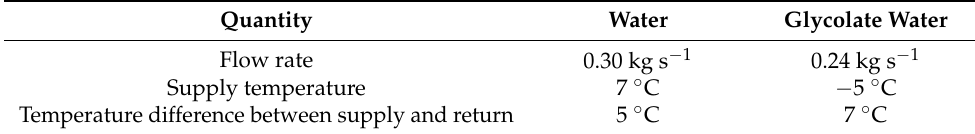
Table 3. Design values for the cooling system sizing.